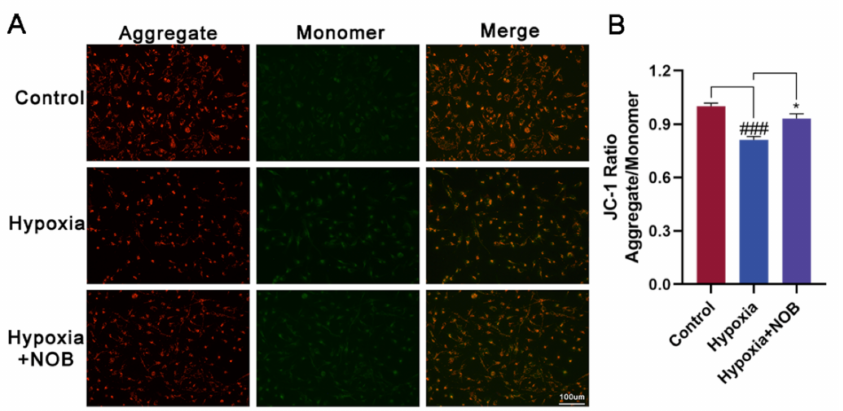
Figure 5. NOB ameliorates mitochondrial dysfunction in activated astrocytes induced by hypoxia for 24 h. ( A ) The JC-1 fluorescent images of astrocytes in different groups. Scale bar, 100 µ m. ( B ) Quantitative analysis of JC-1 fluorescence intensities in astrocytes in different groups. The data are presented as mean ± SD, n = 3, ### p < 0.001 vs. control, * p < 0.05 vs. hypoxia group.